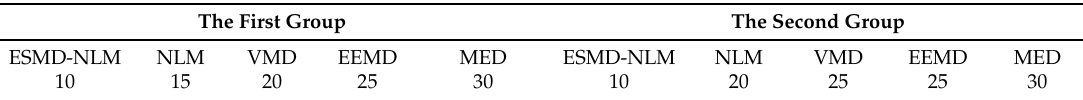
Table 1. The mean MOS error values for the two groups of simulated ECG signals filtered by all evaluated methods.